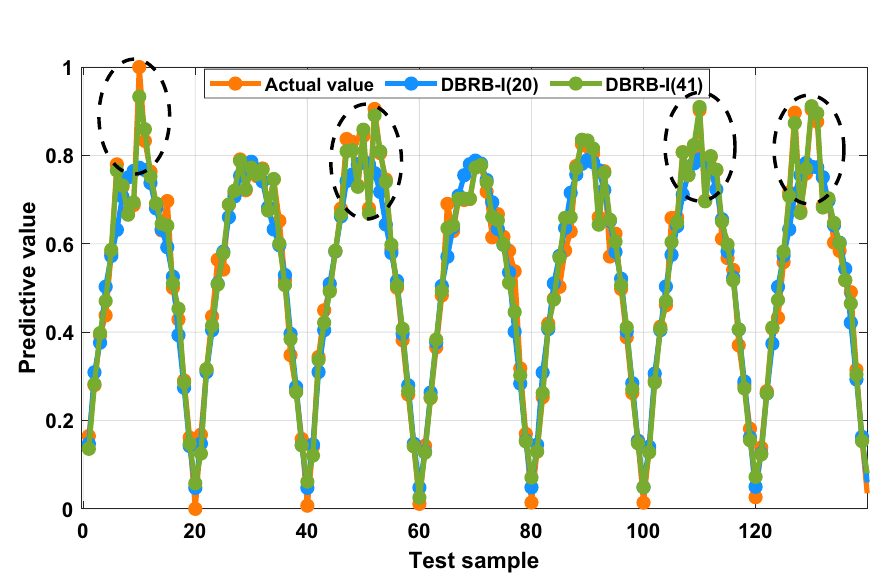
Figure 21. Prediction results of the DBRB-I(41) model.